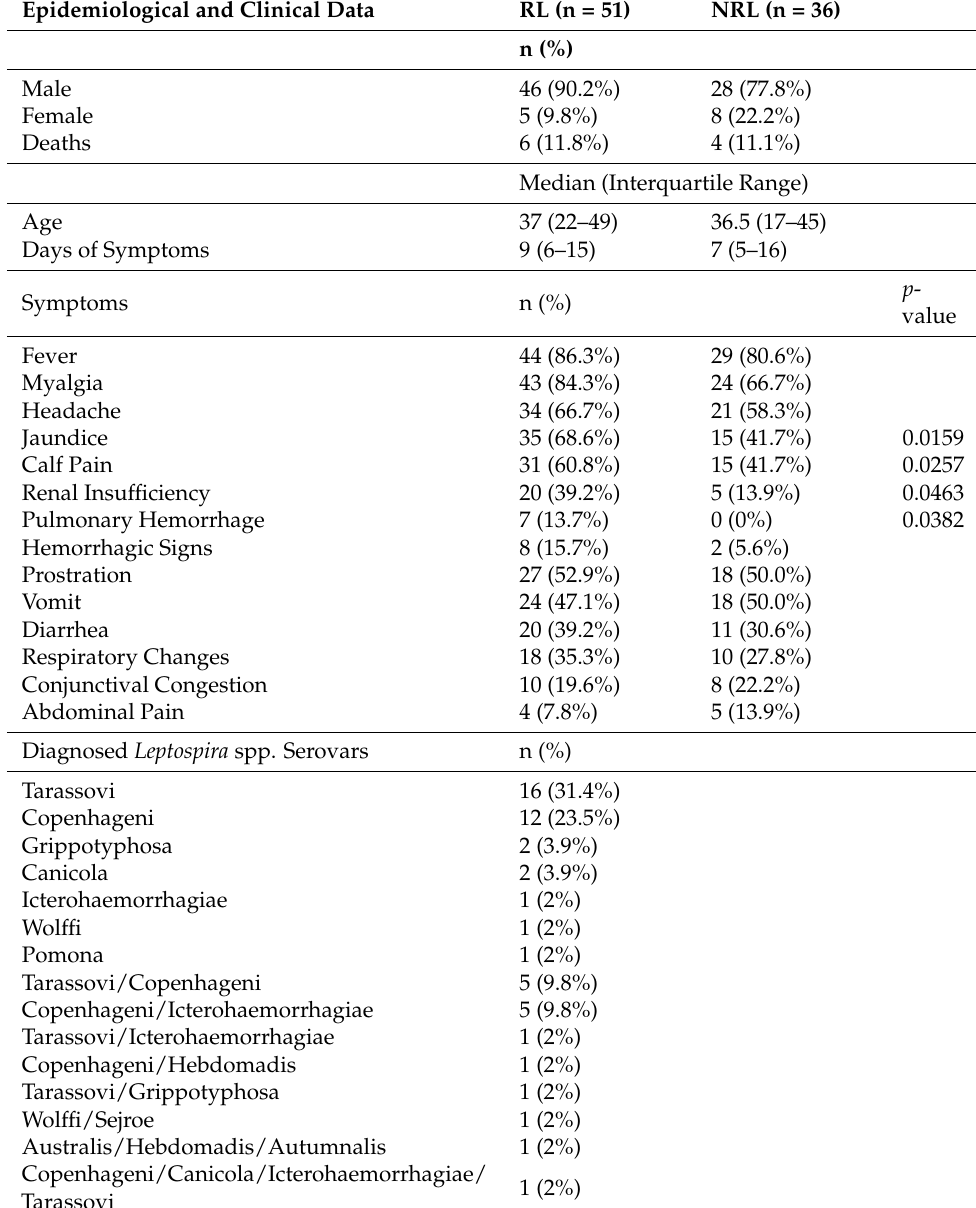
Table 5. Clinical and epidemiological features of the study